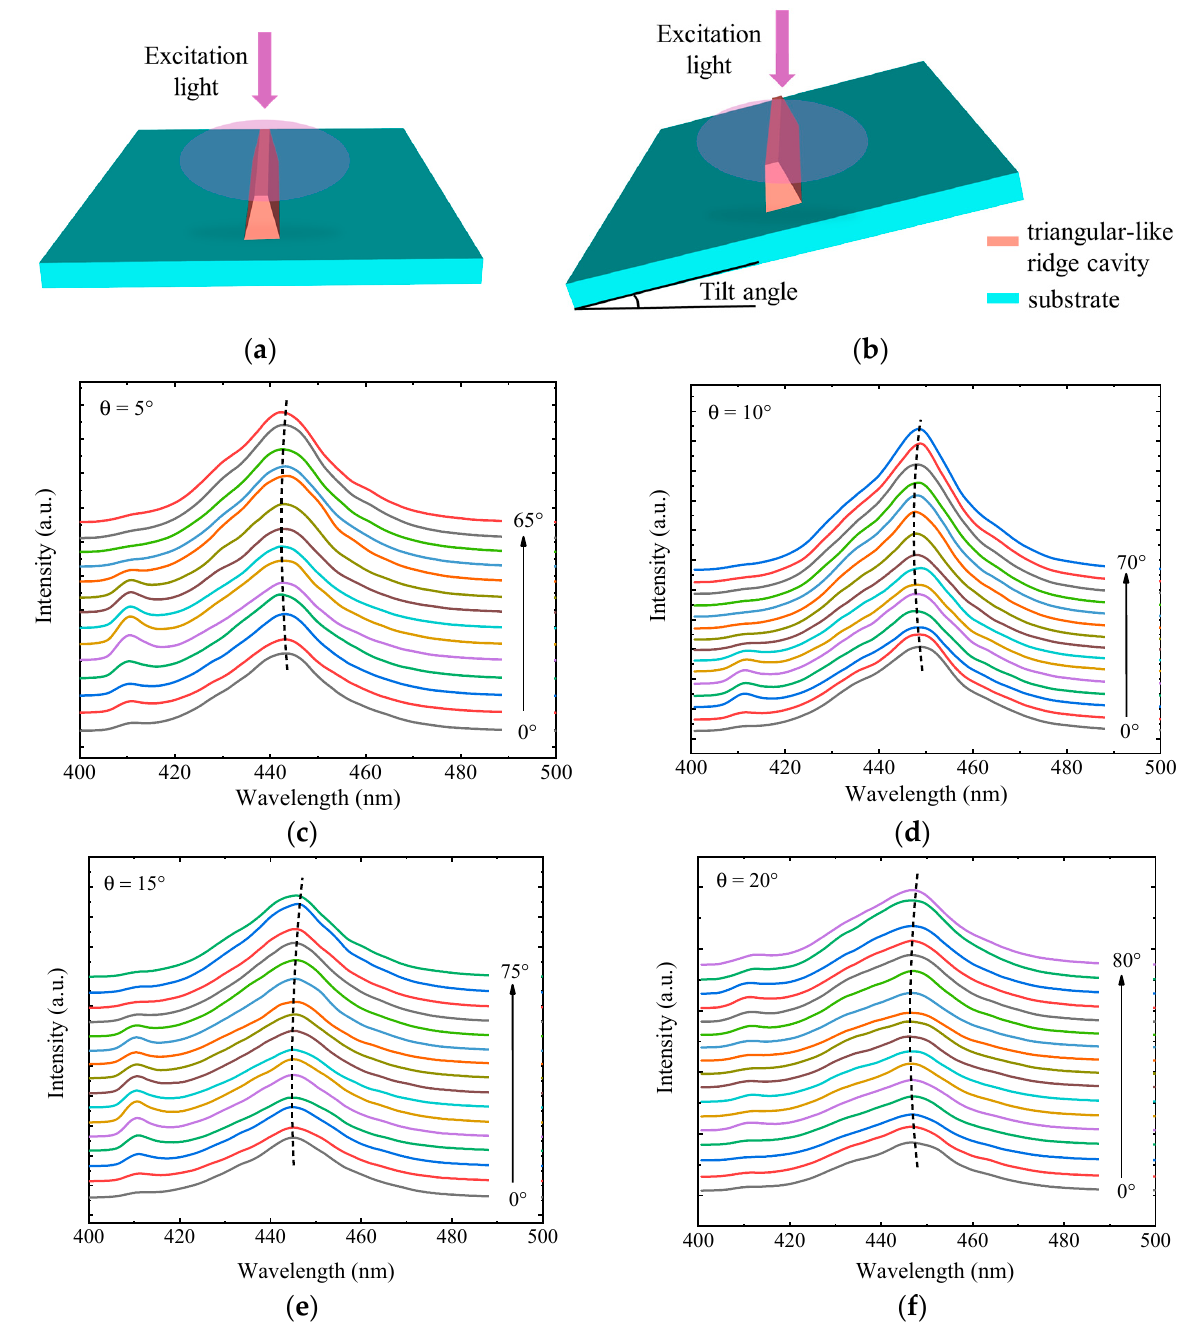
Figure 5. Schematic of the AR-PL measurements ( a ) without and ( b ) with a tilt angle. The ARPL spectra of different tilt angles ( c ) θ =5° ( d ) θ =10° ( e ) θ =15° ( f ) θ =20°.